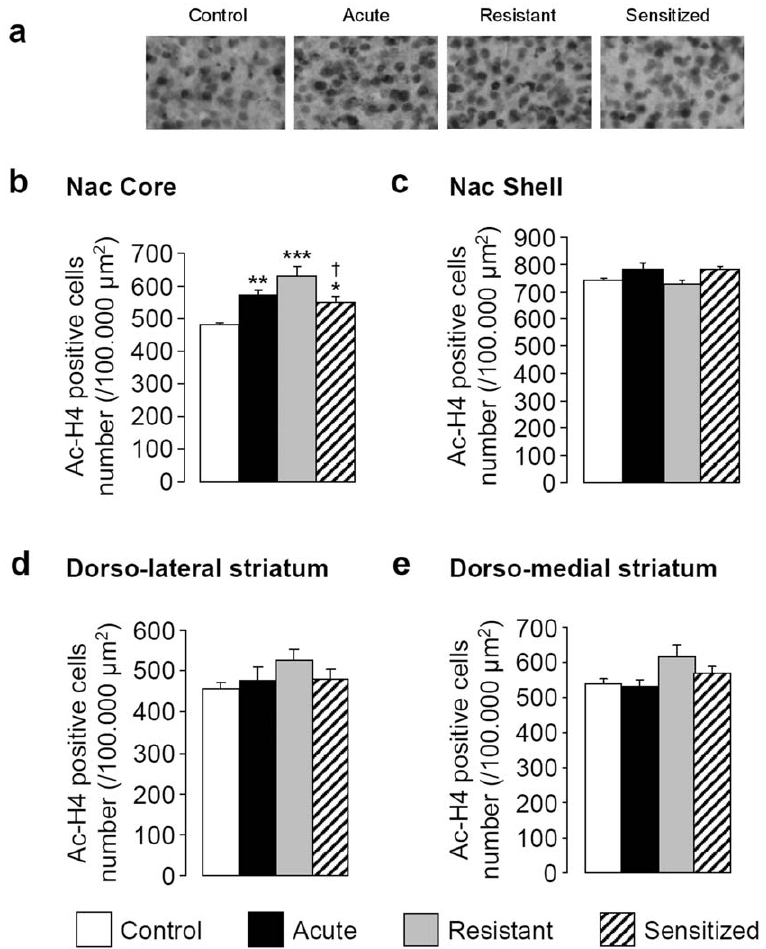
Figure 6. Expression of EIBS is associated with changes in H4K12 acetylation in the core of the Nac. During 10 days, mice received daily i.p. injections of saline or ethanol (2 g/kg) solution. At day 17, mice were challenged with ethanol (2 g/kg) or saline solution and transcardially perfused 30 min later to perform immunohistochemistry (n=4 per group). ( a ) Photomicrographs illustrating the immunolabelling for ac-H4K12 in the core of the Nac. The number of ac-H4K12 positive cells are represented as mean values ( 6 SEM) in the core ( b ) and in the shell ( c ) of the Nac or in the dorso-lateral ( d ) and dorso-medial ( e ) striatum. * P , 0.05, ** P , 0.01, *** P , 0.001 vs control; { P , 0.05 vs resistant groups. Nac, nucleus accumbens.